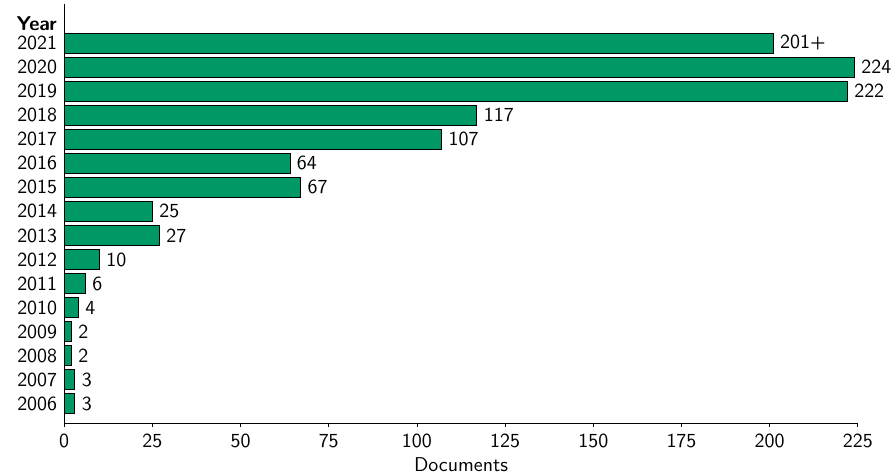
Figure 9. Year-wise published documents worldwide on adopting UAV-PA (until 15 November 2021).